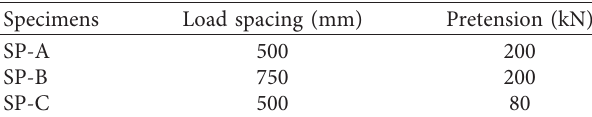
Figure 3: Test setup and servo loading system. Table 2: Design testing parameters in SP-A, SP-B, and